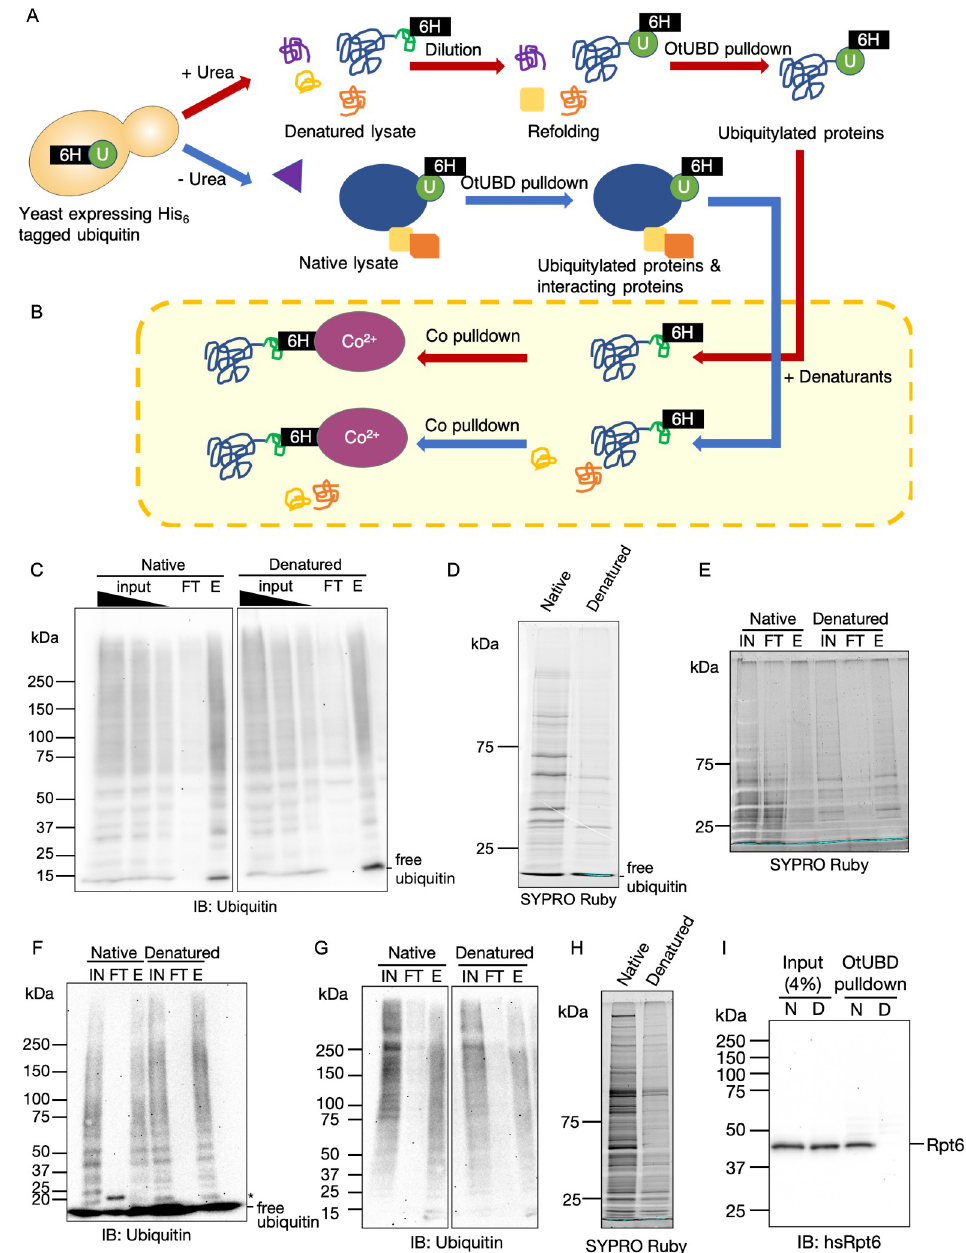
Fig 3. OtUBD pulldown under denaturing condition specifically enriches for proteins covalently modified with ubiquitin. (A) Workflow of OtUBD pulldowns following sample denaturation (red arrows) or under native (blue arrows) conditions. In the first case, cell lysate is treated with 8 M urea to denature and dissociate proteins. The denatured lysate is then diluted 1:1 with native buffer to allow ubiquitin to refold and bind to OtUBD resin. Under such conditions, only ubiquitylated proteins are expected to be enriched. In the second case, cell lysate contains native ubiquitylated proteins as well as proteins that interact with them. OtUBD pulldown under such conditions is expected to yield both ubiquitylated substrates and ubiquitin-binding proteins. (B) Outline for the use of tandem Co 2+ resin pulldowns to validate OtUBD pulldown results under different conditions. Eluates from OtUBD after lysates were incubated with denaturant (red arrows) or left untreated (blue arrows) are (re)treated with denaturant (8 M urea or 6 M guanidine•HCl) and then subjected to IMAC with a Co 2+ resin in denaturing conditions. Proteins covalently modified by His 6 -ubiquitin bind to the Co 2+ resin while proteins that only interact noncovalently with ubiquitin end up in the flow-through. (C) Anti-ubiquitin blot of OtUBD pulldowns following native and urea denaturing treatments performed as described in Fig 3A. FT, flow-through; E, eluted fractions. The image was spliced to remove